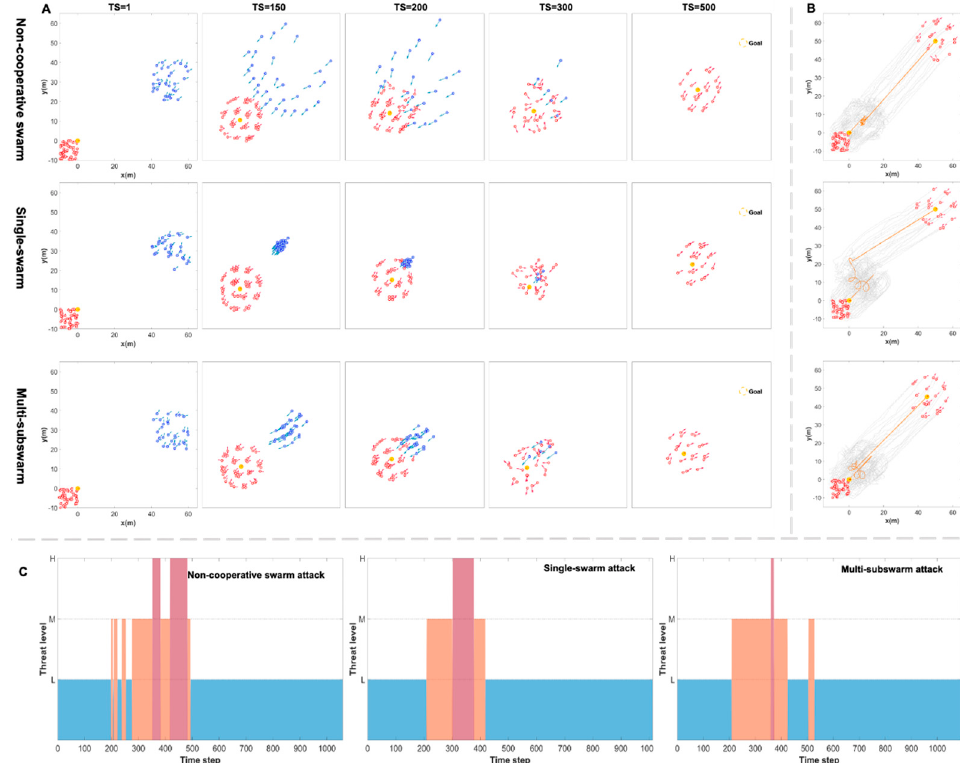
Figure 6. Simulations of 50 defenders escorting the HVU under the attack of 30 aggressive individ- uals with different attacking patterns. ( A ) Snapshots of simulations. ( B ) Trajectories of the escort individuals (light gray lines) and HVU (orange line). ( C ) Threat assessment of the